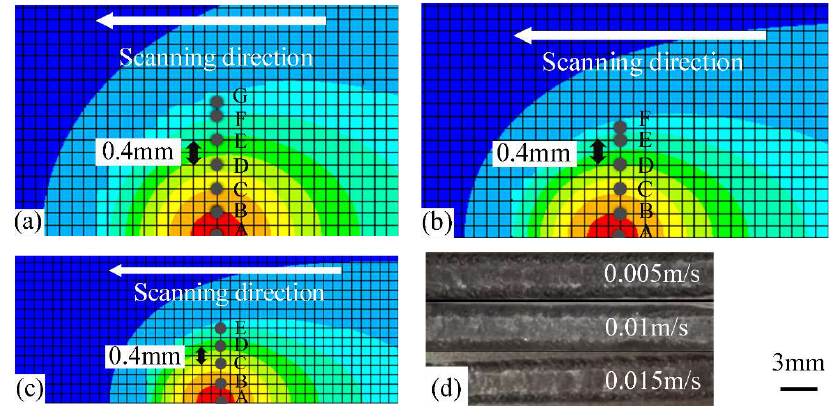
Figure 11. The surface temperature monitoring point of the molten pool at different scanning speeds: ( a ) 0.005 m/s, 1500 W, 3 s; ( b ) 0.01 m/s, 1500 W, 1.5 s; ( c ) 0.015 m/s, 1500 W, 1 s; and ( d ) the experimental result.